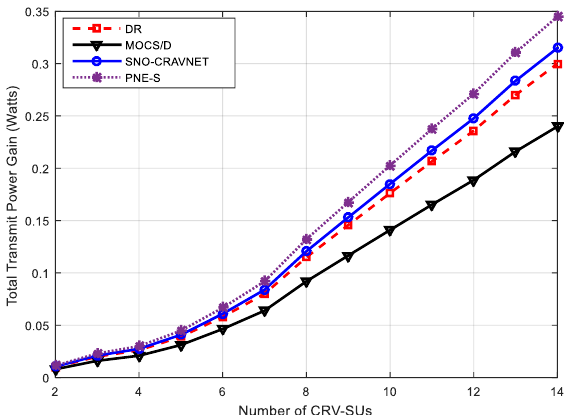
Figure 6. Performance evaluation using the total transmit power gain measured against a varying number of CRV-SUs. number of